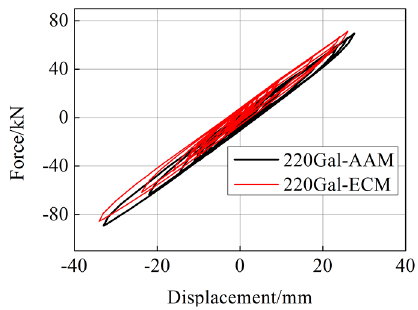
Figure 11. Hysteretic loops of specimen (220 Gal).